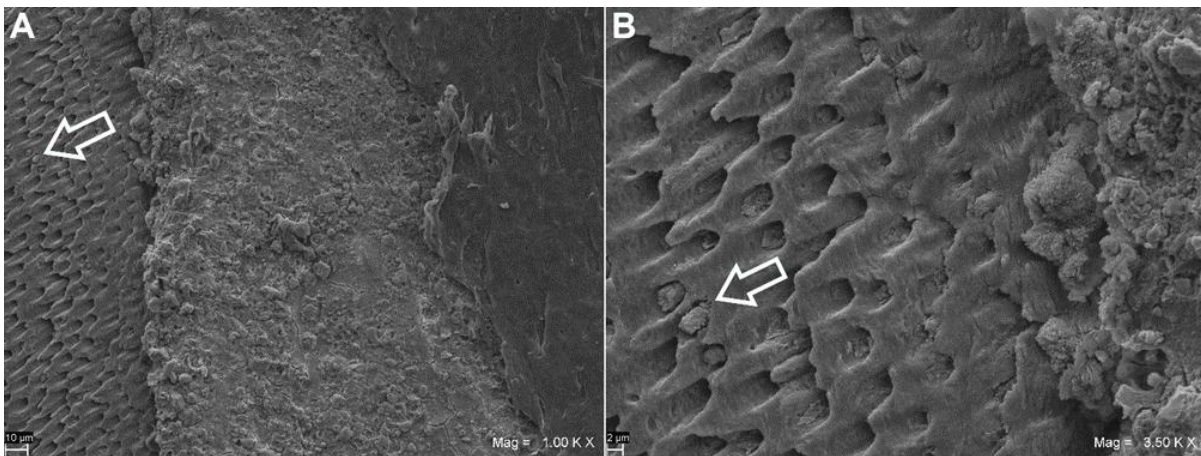
Figure 3. Scanning electron microphotograph (( A ), original magnification 1000×; ( B ), original magnification 3500×) of a sample obturated with a bioceramic-based root canal sealer and warm vertical condensation. Sealer penetration into the dentinal tubules may be observed (arrows).